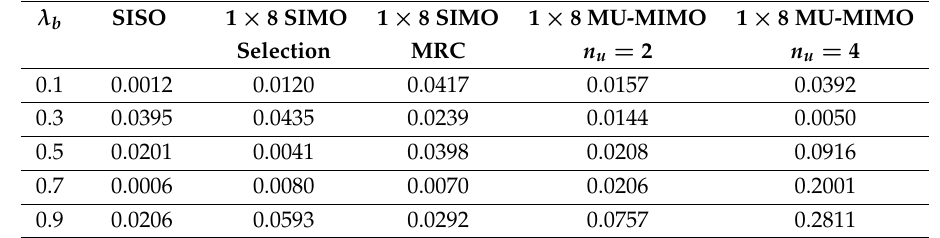
Table 3. The percentage change ∆ m N / m N , s of the theoretical values m N and the empirical values m N , s . λ b